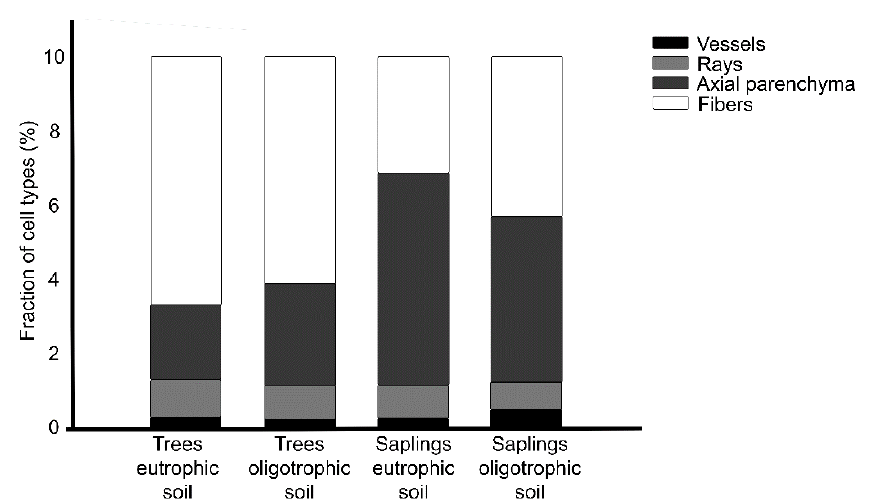
Figure 4. Fraction of cell types (%) of Enterolobium contortisiliquum 9-year-old trees and 2-year-old saplings in eutrophic and oligotrophic soil. Bars: black = vessels fraction; white = fibers fraction; dark grey = parenchyma fraction; light grey = rays fraction.